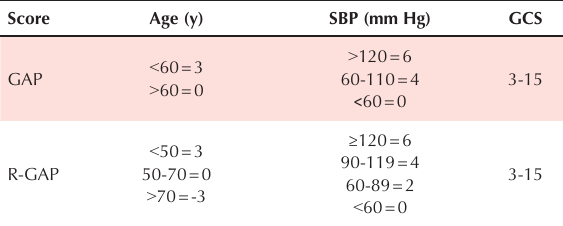
Table 1 . Calculation method of GAP and R-GAP